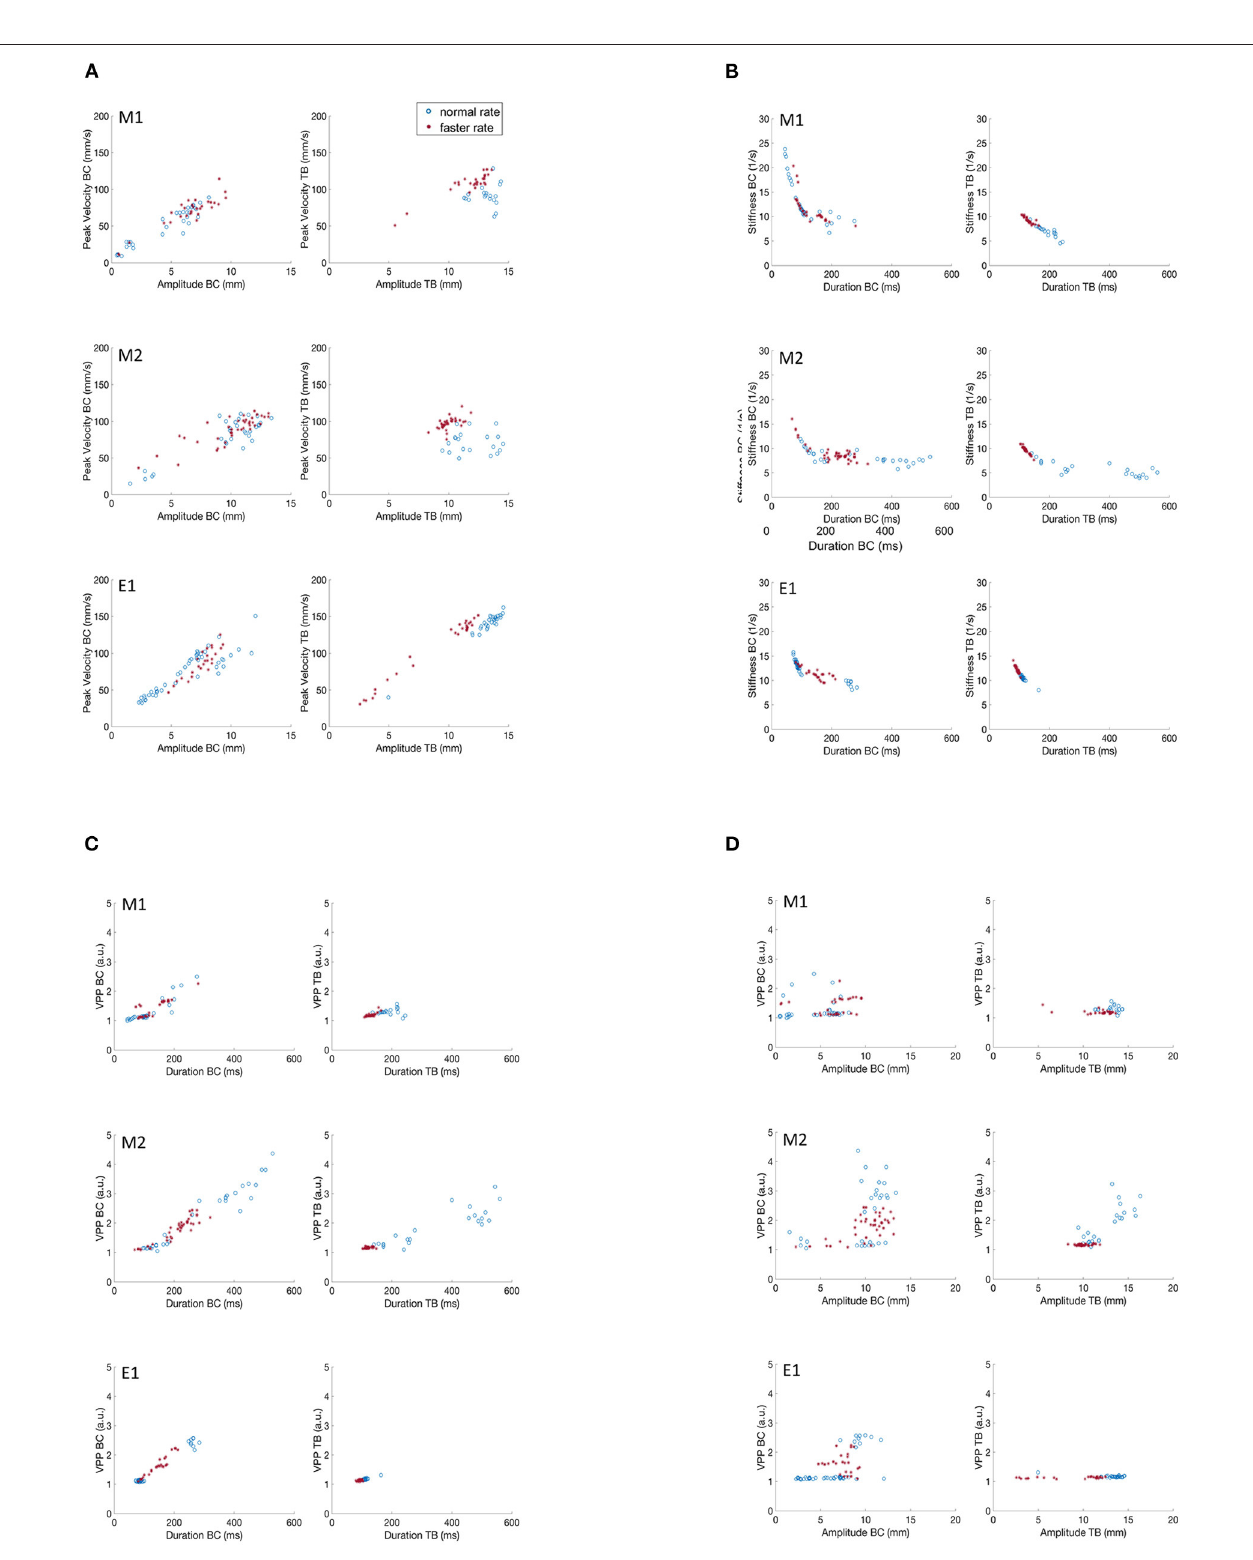
FIGURE 4 | Covariation of kinematic parameters of BC and TB gestures for M1, M2 and E1 for productions of /ipa/. (A) Peak velocity vs. movement amplitude. (B) Stiffness vs. duration. (C) Velocity profile parameter vs. duration. (D) Velocity profile parameter vs. amplitude.